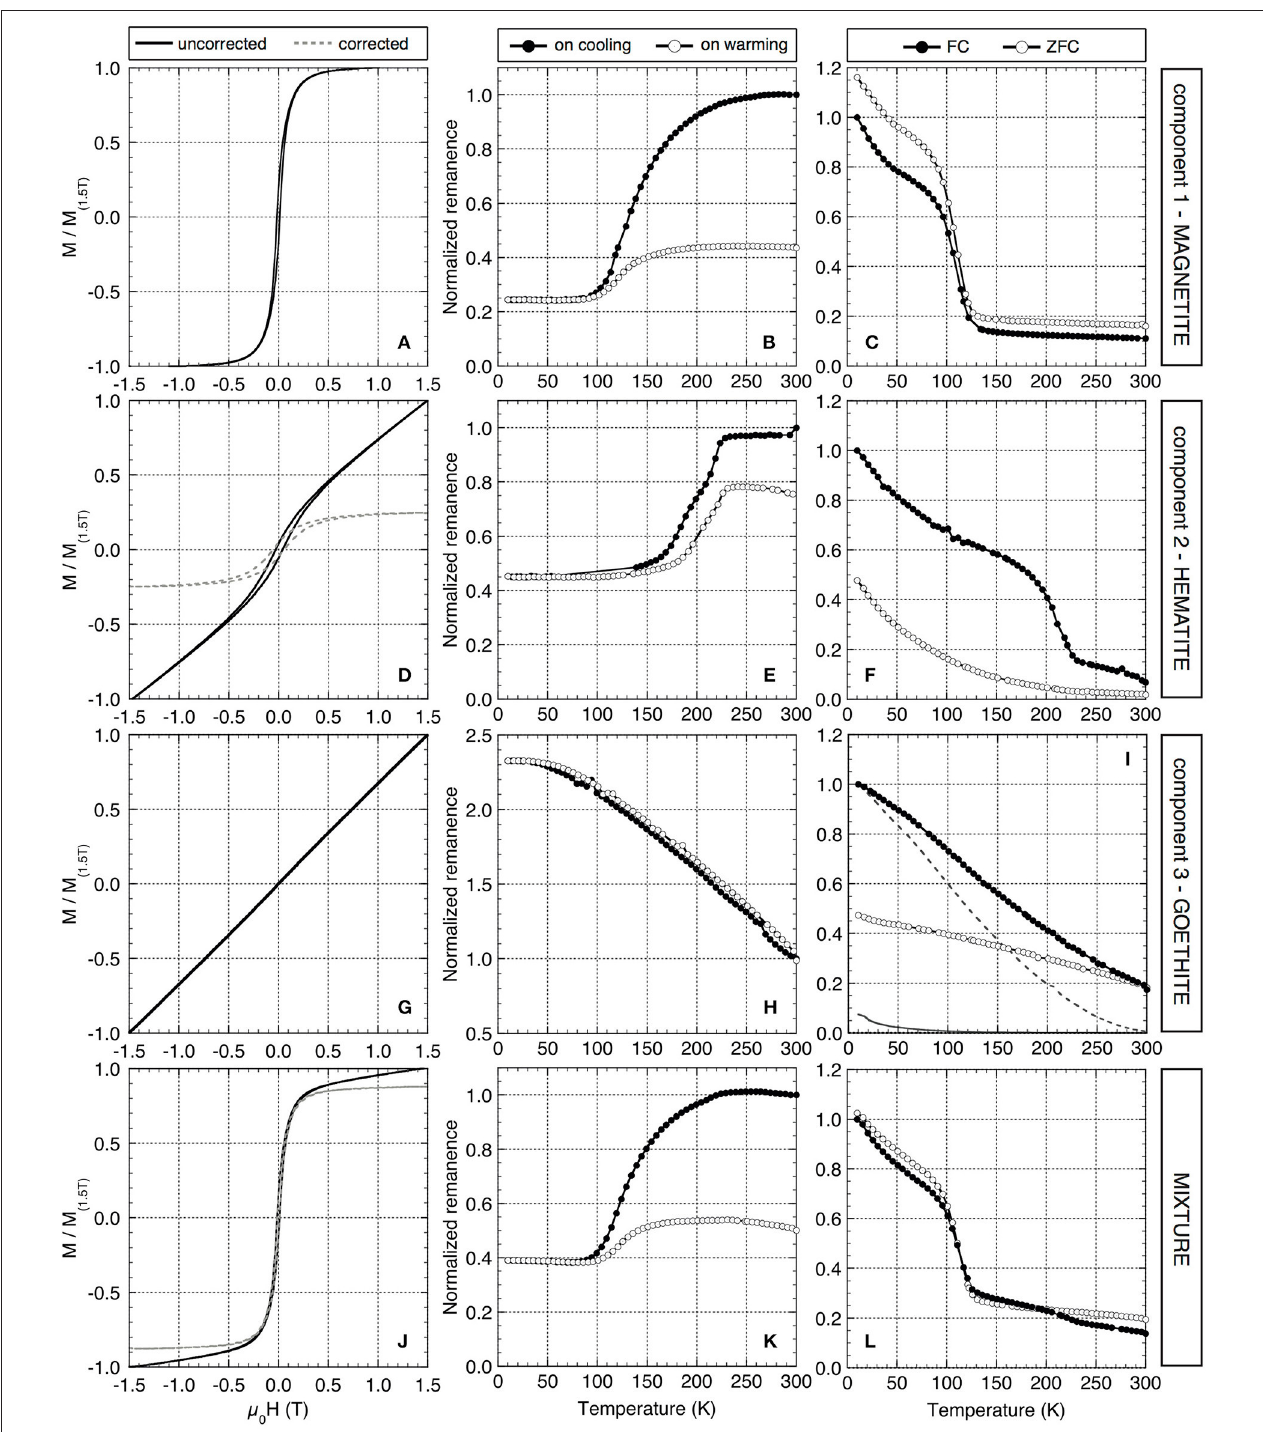
FIGURE 2 | Characterization of the magnetic behavior of the individual components, magnetite (A–C) , hematite (D–F) and goethite (G–I) , and the mixture (J–L) is shown. Room temperature hysteresis loops (A,D,G,J) are normalized to the uncorrected for high-field slope loop magnetization induced in the maximum 1.5 T field. Room temperature (300 K) IRM acquired in a 2.5 T field (RT-SIRM) is monitored on cooling and warming and remanence values are normalized to the initial RT-SIRM. Low temperature (10 K) IRM acquired in a 2.5 T field is monitored on warming after cooling in zero field (ZFC) or cooling in a 2.5 T field (FC) and remanence values are normalized to the initial FC value at 10 K. All normalizing values and hysteresis loop derived parameters are listed in Table 1 . RT-SIRM data in (H,K) are enhanced RT-SIRM and ZFC and FC experiments in (I,L) were acquired without thermally demagnetizing the enhanced RT-SIRM. The gray ZFC (solid) and FC (dashed) curves in (I) are data acquired on the pristine goethite powder sample prior to any “enhancing” pre-treatments.